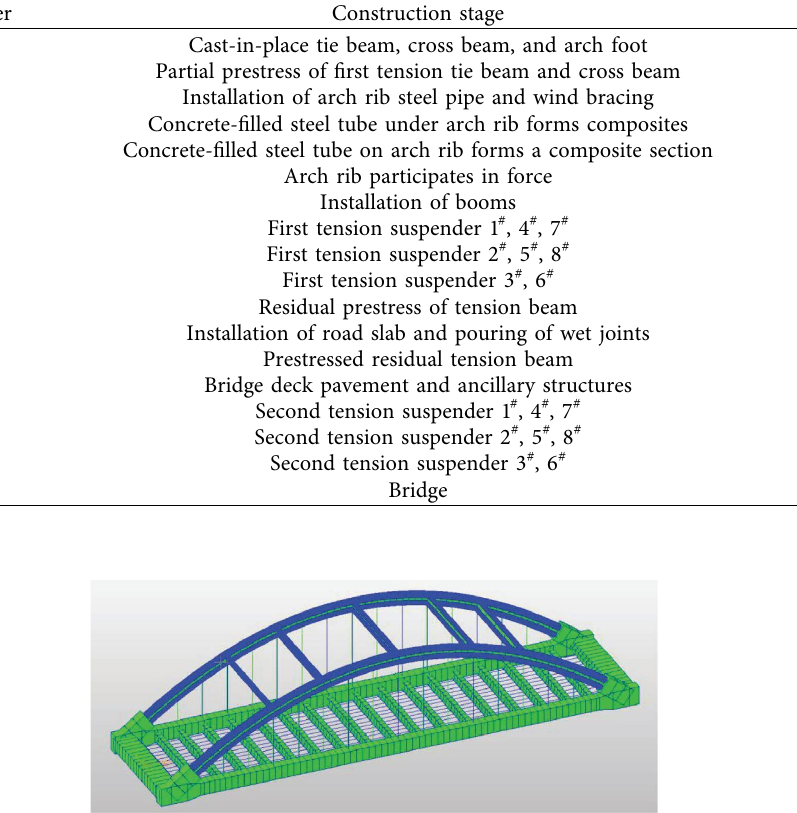
Figure 3: Midas civil bridge